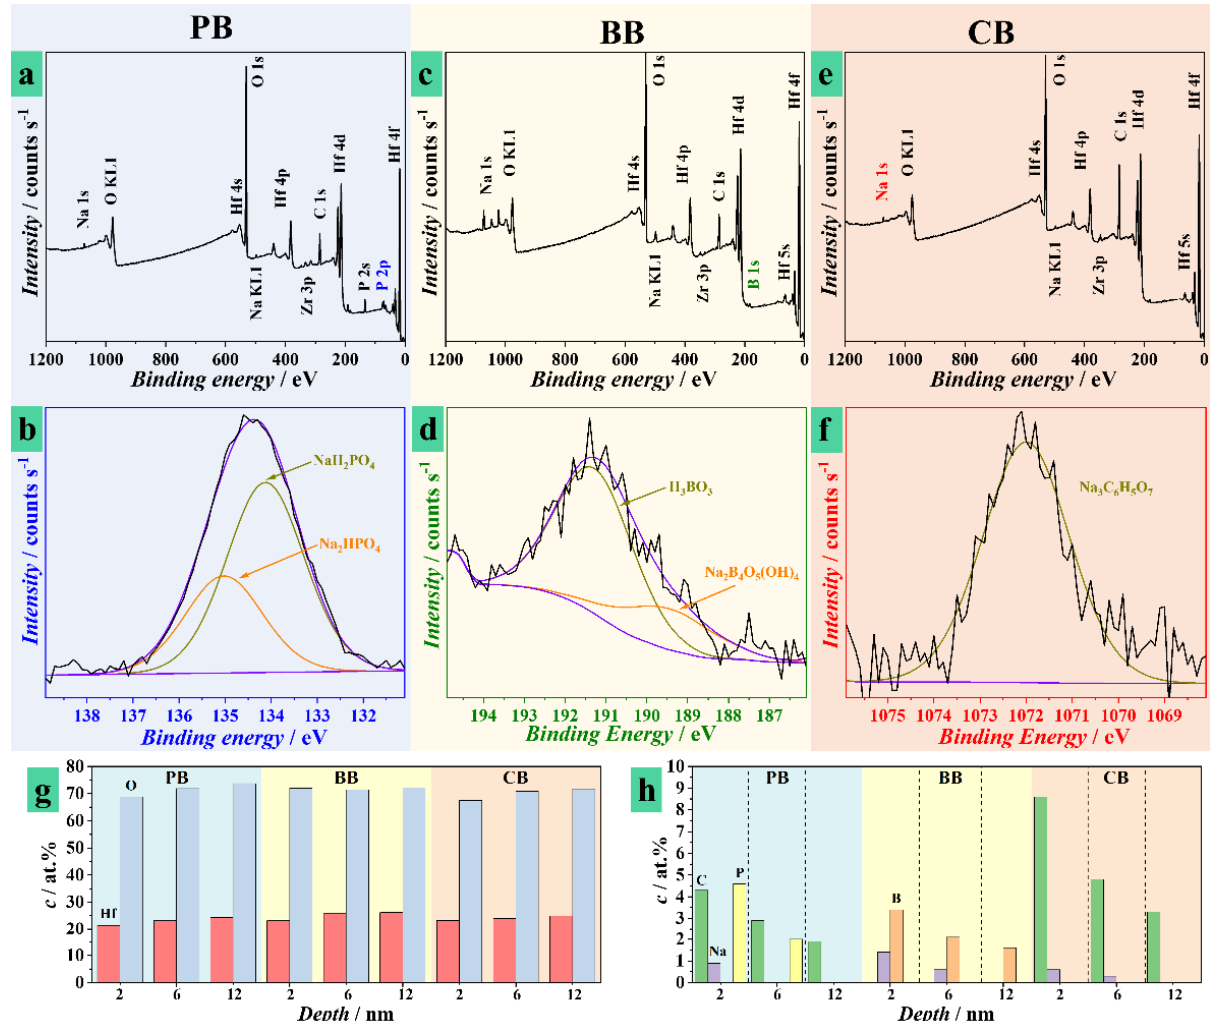
Figure 2. Chemical analysis of HfO 2 grown in different electrolytes: surface XPS surveys ( a , c , e ) with corresponding high-resolution analysis of relevant peaks ( b , d , f ) and quantitative analysis as obtained during depth profiling for Hf and O ( g ) and electrolyte species ( h ).